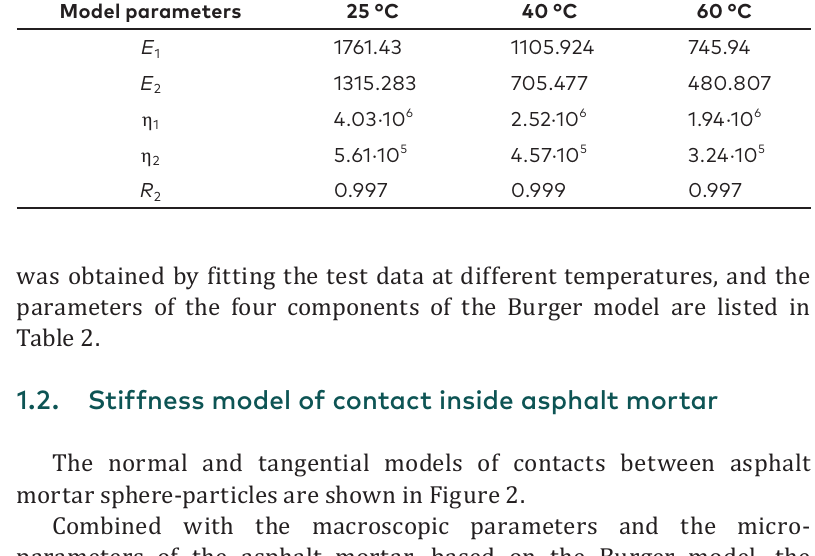
Stiffness model of contact inside asphalt mortar